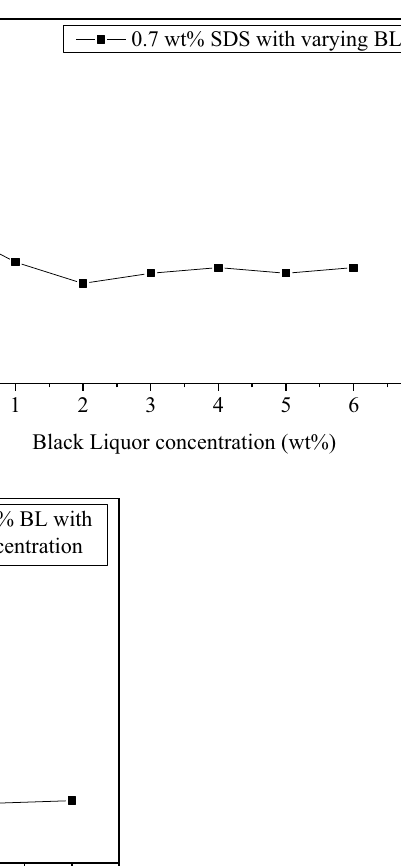
2 CO 3 at different concentrations with crude